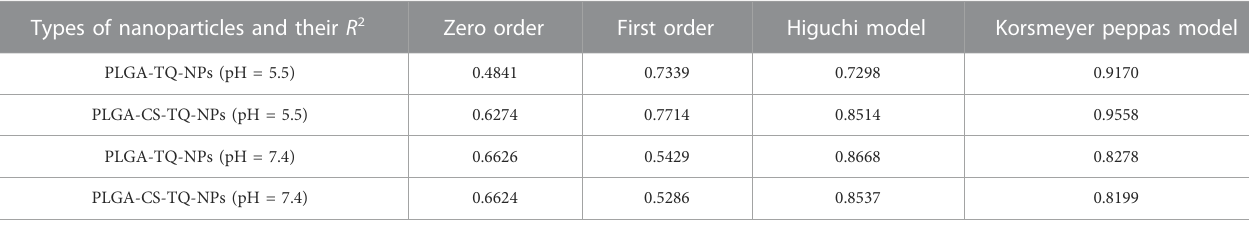
TABLE 4 Represents the R 2 (correlation value) values obtained from different models.